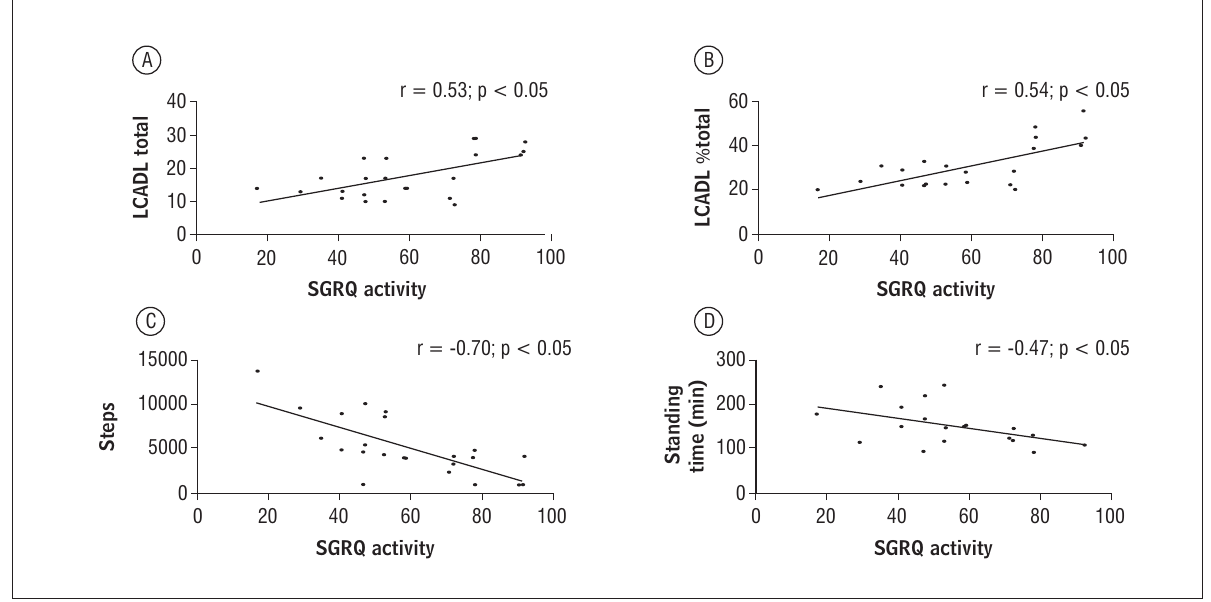
Figure 2 - (A) Correlation between the domain ‘activity’ of the SGRQ and the total score of the LCADL. (B) Correlation between the domain ‘activity’ of the SGRQ and the percentage of total score of the LCADL. (C) Correlation between the domain ‘activity’ of the SGRQ and the number of steps. (D) Correlation between the domain ‘activity’ of the SGRQ and standing time Source: Research